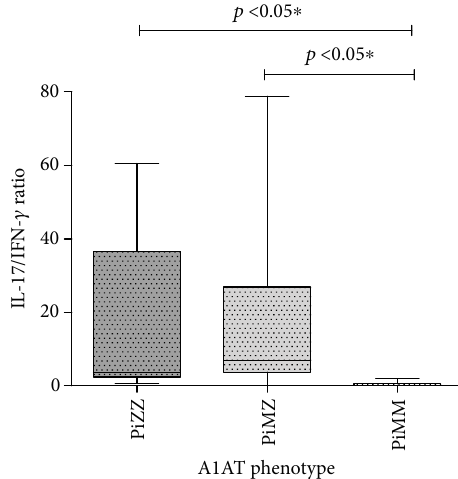
Figure 3: Comparison of IL-17/IFN- γ ratios in COPD patients with PiZZ, PiMZ, and PiMM phenotypes of A1AT.